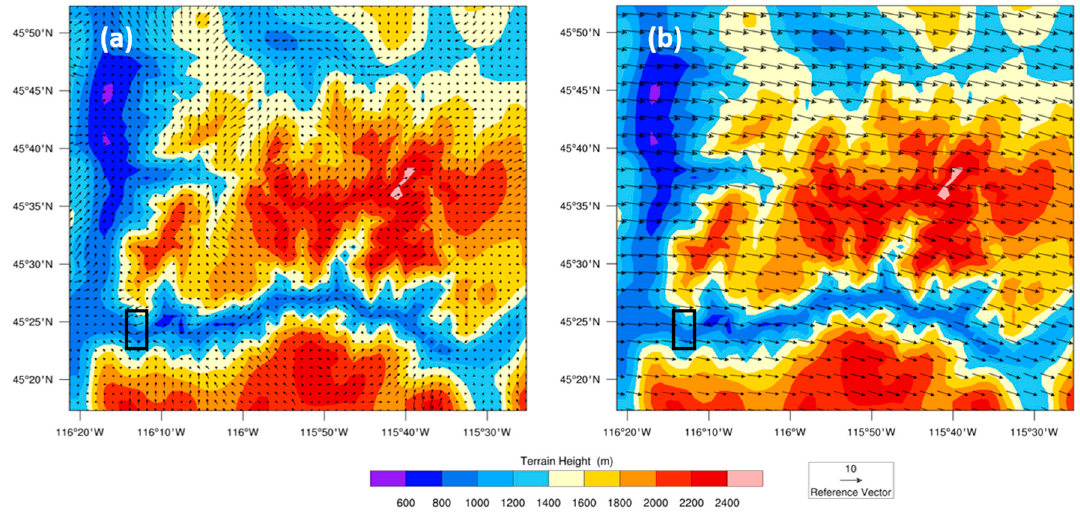
Figure 9. Simulated: ( a ) 10-m winds; and ( b ) 700-mb winds in the 1.33 km domain at 0900 LT on event day 17 August. The black box delineates the study area.